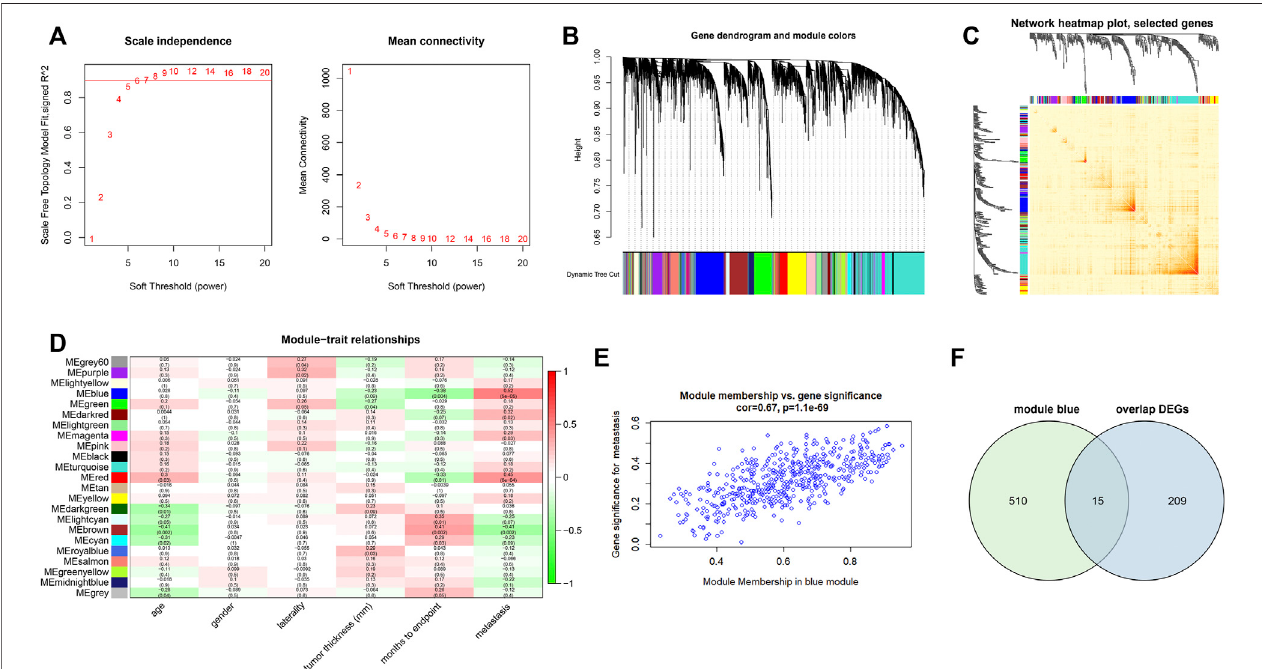
FIGURE4| Constructionofco-expressionmodulesandmodule-traitrelationship. (A) Analysisofnetworktopologyforsoftthresholdpowervalues. (B) Hierarchical clustering dendrogram of probe sets with dissimilarity in accordance with topological overlap and assigned module colors. (C) Network heatmap plot with topological overlap matrix among 400 randomly selected genes. (D) Module-trait relationships. A total of 22 modules were identi fi ed in this study. The clinical traits included age, gender, laterality, tumor thickness, months to the endpoint and metastasis. (E) The scatterplots of blue module membership vs. gene signi fi cance for metastasis. (F) Venn diagram showing 15 intersecting genes between overlapped DEGs and blue